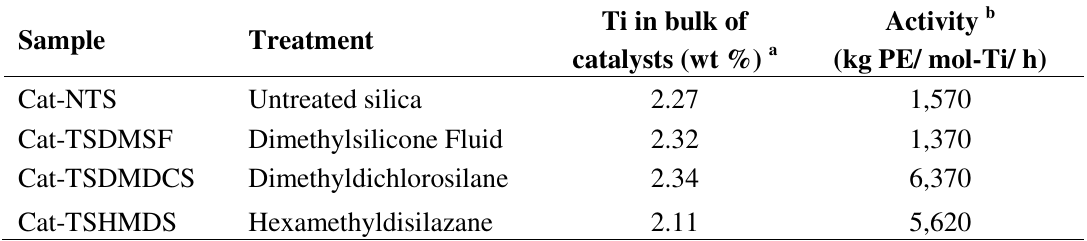
Table 1. Ti content in bulk and activity of different catalysts.